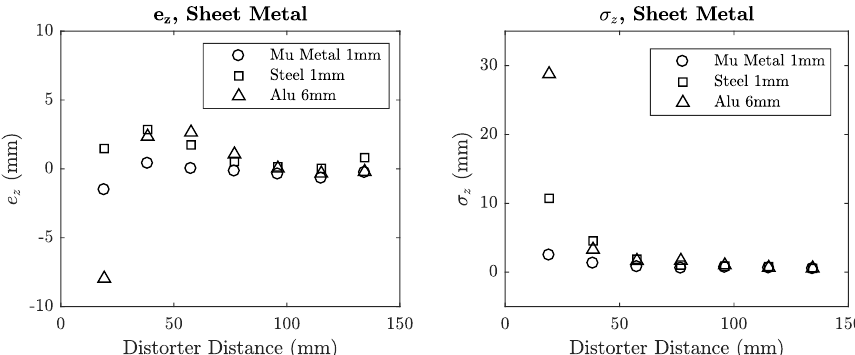
Figure 16. Mean error and standard deviation for sheet metal distorters.